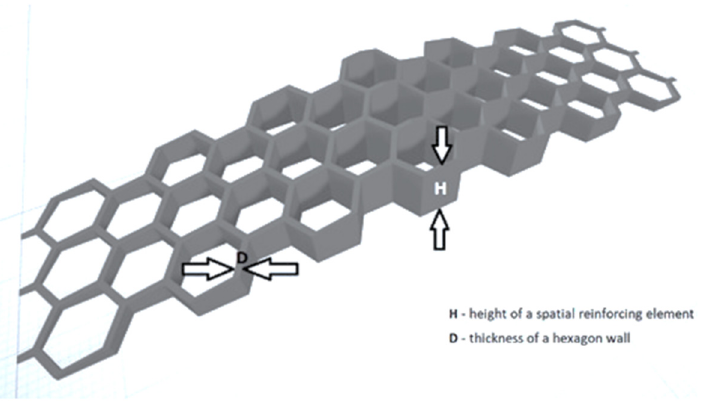
Figure 7. General view of the designed spatial reinforcing element. Image created by A. Skoratko (inspired by [55]).